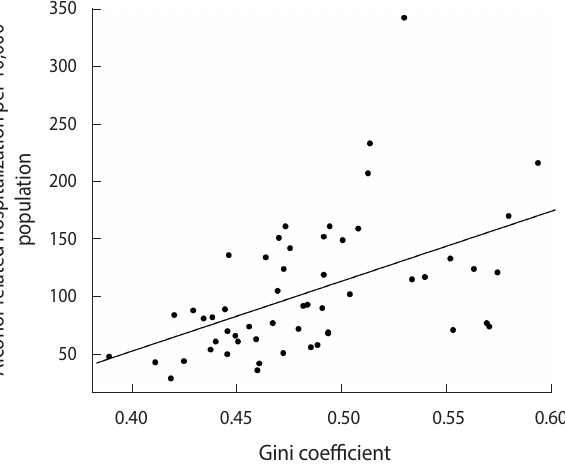
Figure 1. Alcohol-related hospitalizations (2010-2014) and Gini co- efficients for New York City public use microdata area (R 2